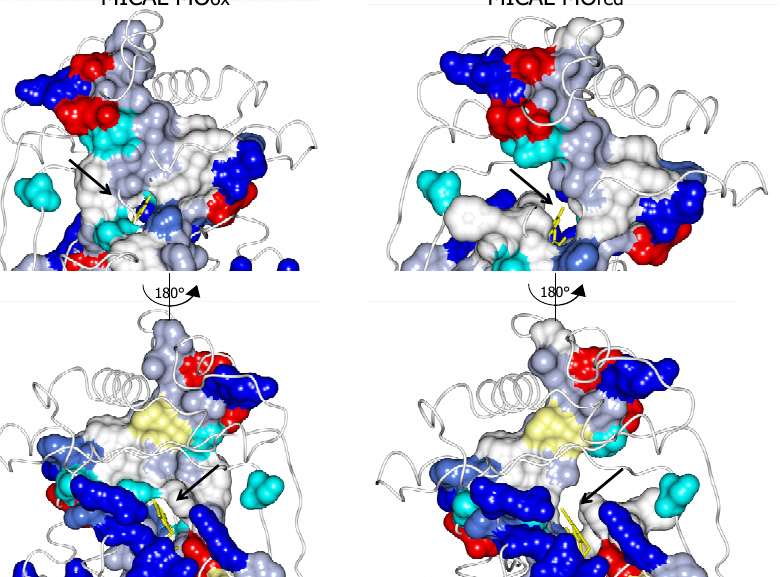
Figure 8. Details of the “flavin out” (MICAL-MO ) and “flavin in” (MICAL-MO ) ox red conformations of MICAL-MO highlighting the conserved residues forming the tunnel leading to the active site in the “flavin in” conformation. The residues in the conserved regions surrounding the FAD isoalloxazine ring (arrows) and comprising residues 121–130, 278–300 and 390–405 (red stars in Figure 4) are shown. The views correspond to those shown in Figure 7. Color code is also as in Figure 7 except for FAD that is in sticks and yellow. The CCP4MG program was used to generate the figure